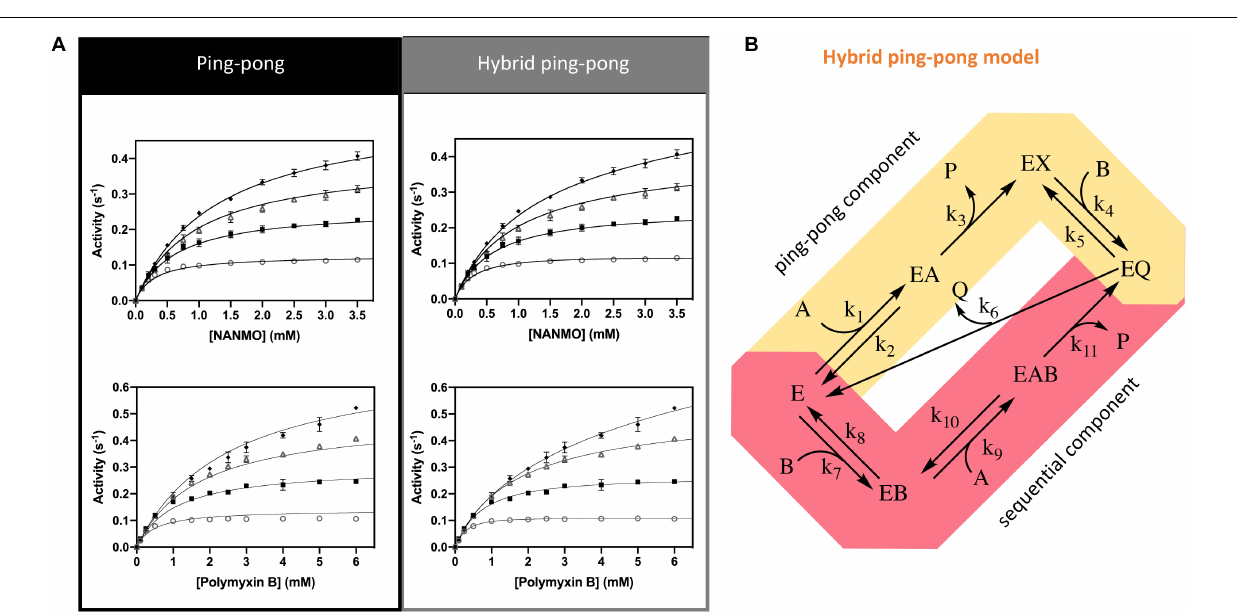
FIGURE 6 | Kinetic mechanism and fitting of kinetic data to two kinetic models. (A) Ping-pong and hybrid ping-pong kinetic models fitted to a series of kinetic curves toward acetylation of NANMO or polymyxin B at varying concentrations of AcCoA. (B) Hybrid ping-pong model with two components: a ping-pong path and a sequential path. E is enzyme, EX is acetylated enzyme, A is AcCoA, B is acceptor substrate (polymyxin B or NANMO), P is CoA, and Q is acetylated acceptor product. The hybrid model allows free enzyme to bind AcCoA or acceptor substrate at the same time. If it binds AcCoA first, the enzyme becomes acetylated and the ping-pong path is used, whereas if acceptor substrate binds first the acetyl group of AcCoA can be transferred directly to acceptor substrate using the sequential path (see section “Materials and Methods” for more